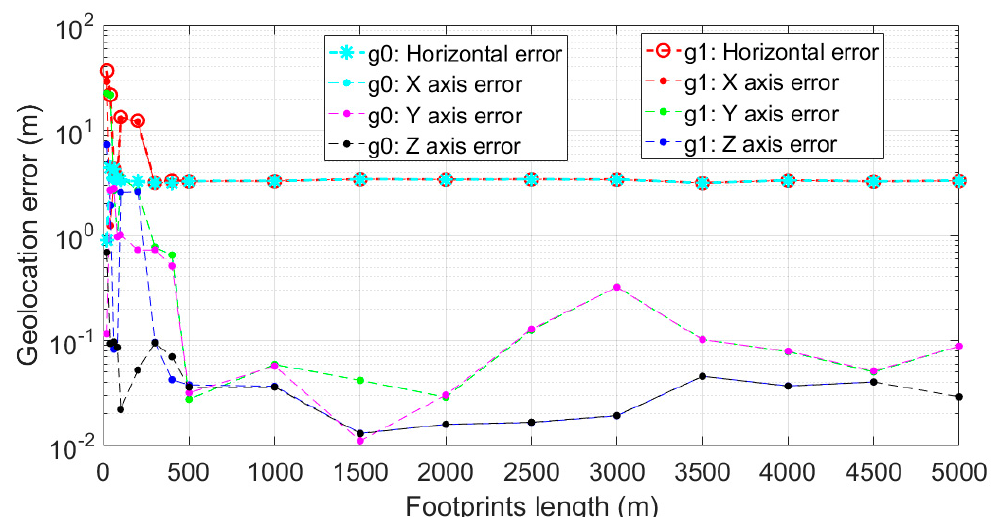
Figure 17. Calibration results with different track lengths. Group “g0” is the calibration result with no additional offsets added in the ICESat-2 data, and group “g1” is the calibration result when additional offsets of 12 m, 12 m and 0.5 m were added in the x-axis, y-axis, and z-axis of each point, respectively, in the geographic coordinate system. The horizontal errors are calculated by , where e x and e y are the errors in the x-axis and y-axis, respectively.